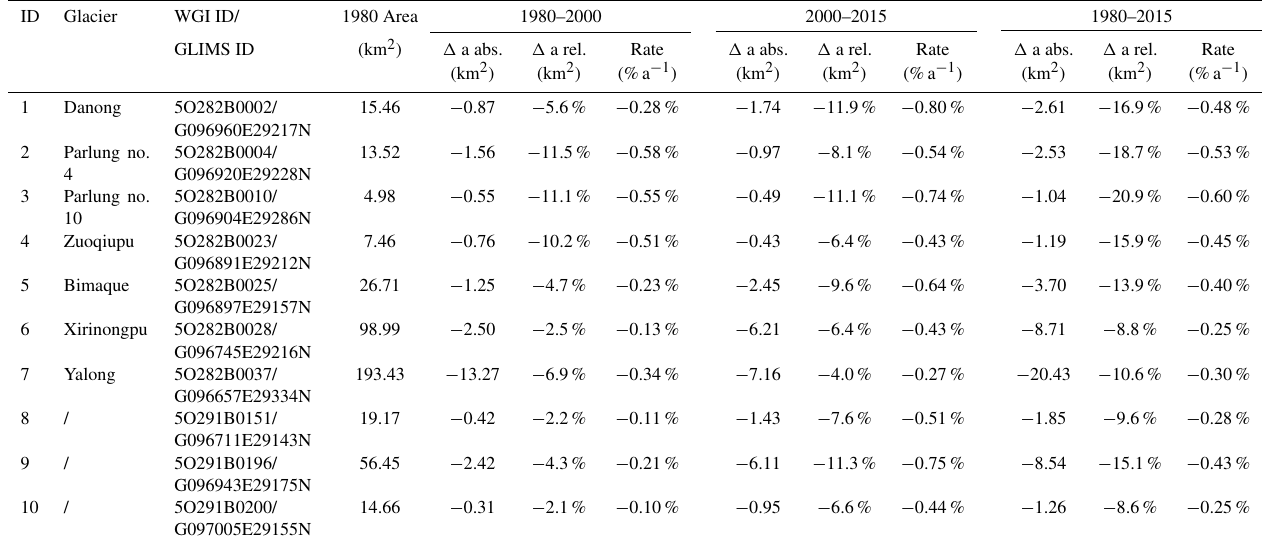
Table 4. Area changes for 10 sample glaciers in the Kangri Karpo. ID